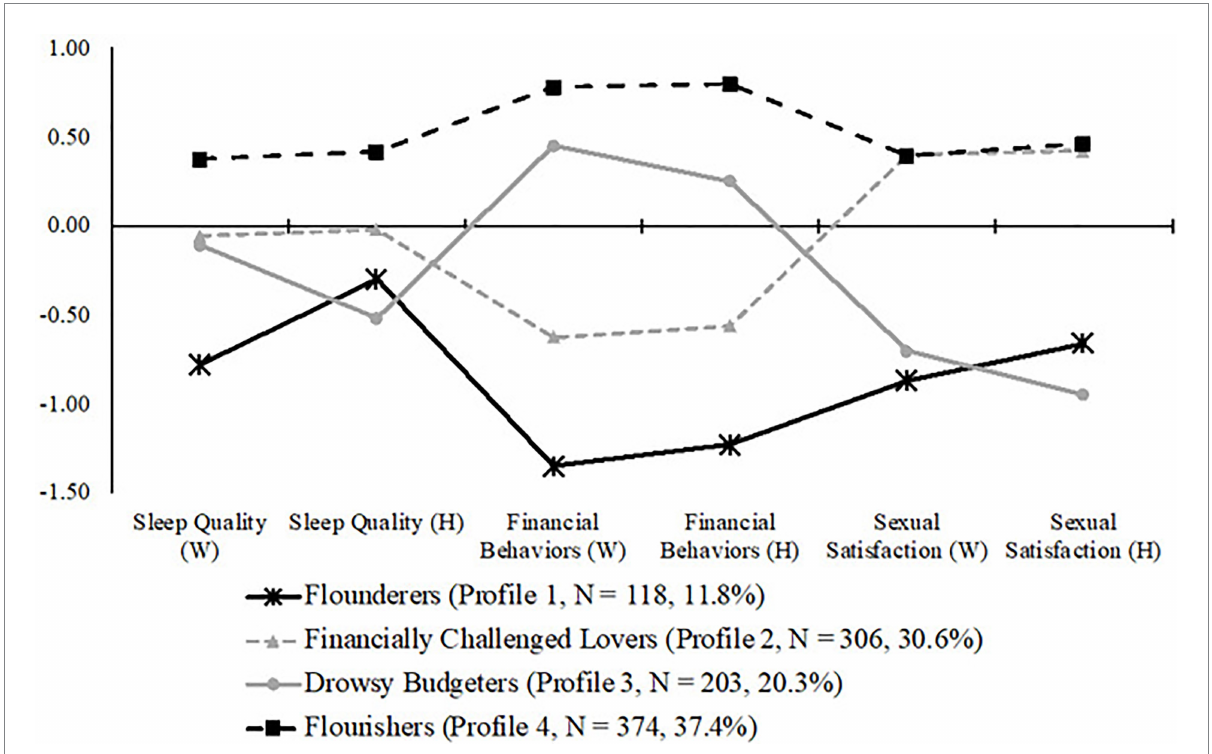
FIGURE 2 Latent profiles based on Z scores of indicators ( N = 1,001 couples). The 0 on the y -axis indicates the average level across the whole sample of 1,001 couples. Positive values on the y -axis represent higher levels in comparison with the sample mean, and negative values on the y -axis represent lower levels in comparison with the sample mean. For space constraints, we labeled financial management behaviors as “financial